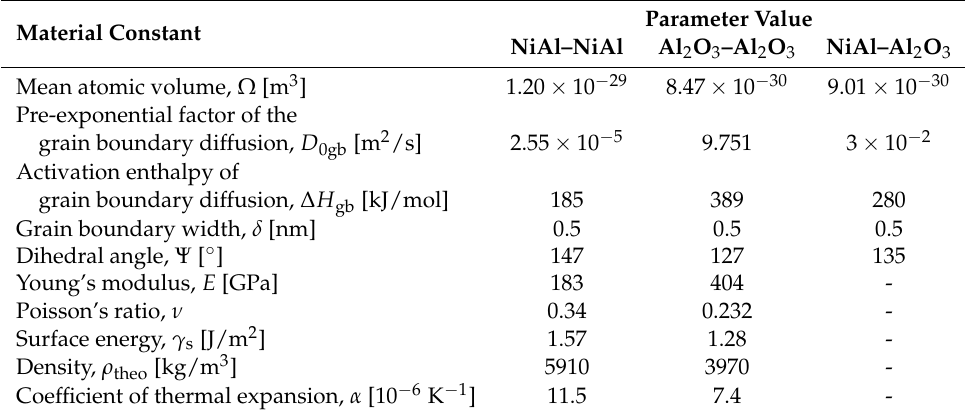
Table 1. Materials model parameters of different contact